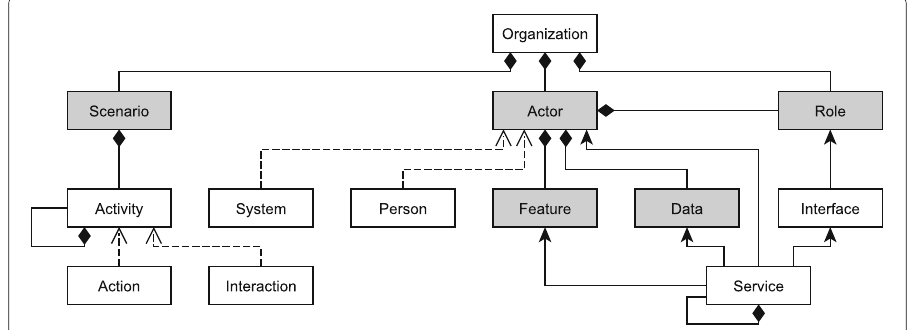
Fig. 1 Representation of the established metamodel for capturing domain